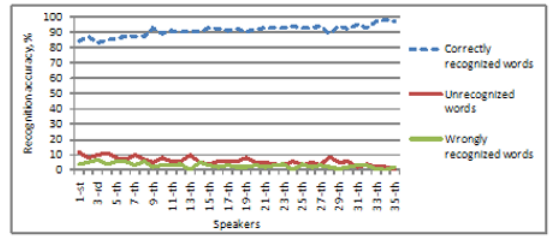
Figure 3. Long voice commands recognition results using the initial corpus and 2 LBT based transcriptions.